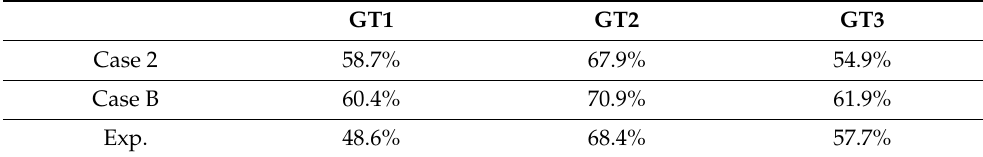
Table 5. This table displays the SO 2 removal efficiencies of small-scale tower by numerical and experimental results [36] at different sampling points as L / G = 3.2.